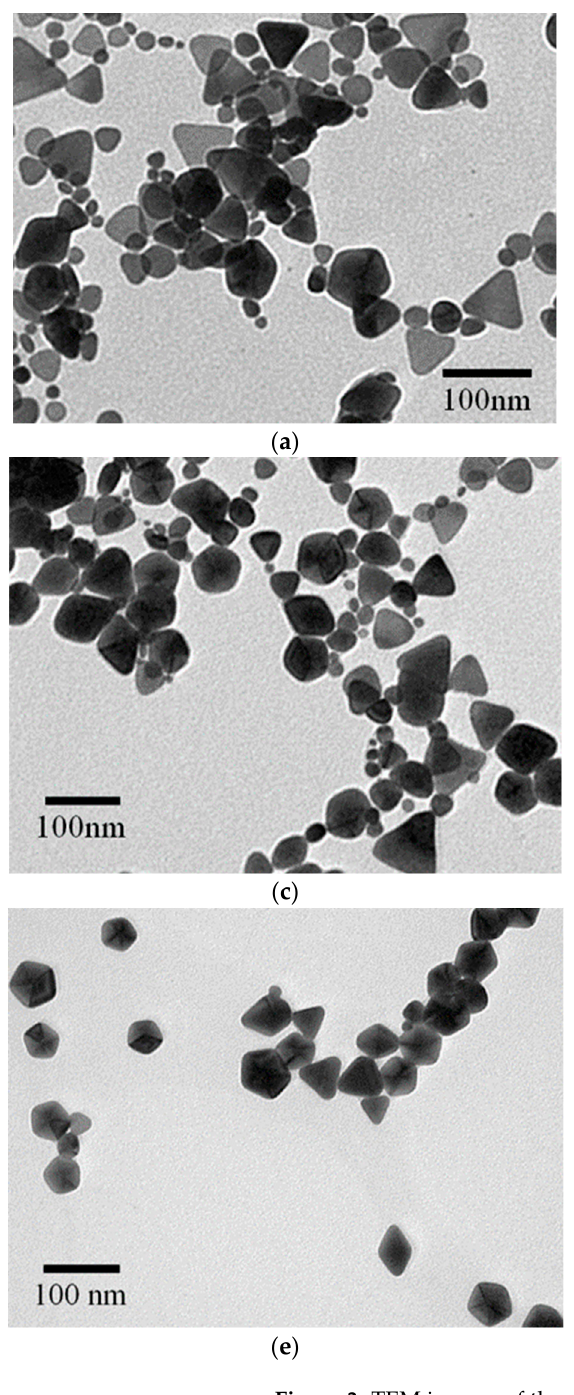
Figure 3. TEM images of the silver nanostructures synthesized at various temperatures: ( a ) 60 °C; ( b ) 40 °C; ( c ) 30 °C; ( d ) 20 °C; ( e ) 10 °C; ( f ) 0 °C.